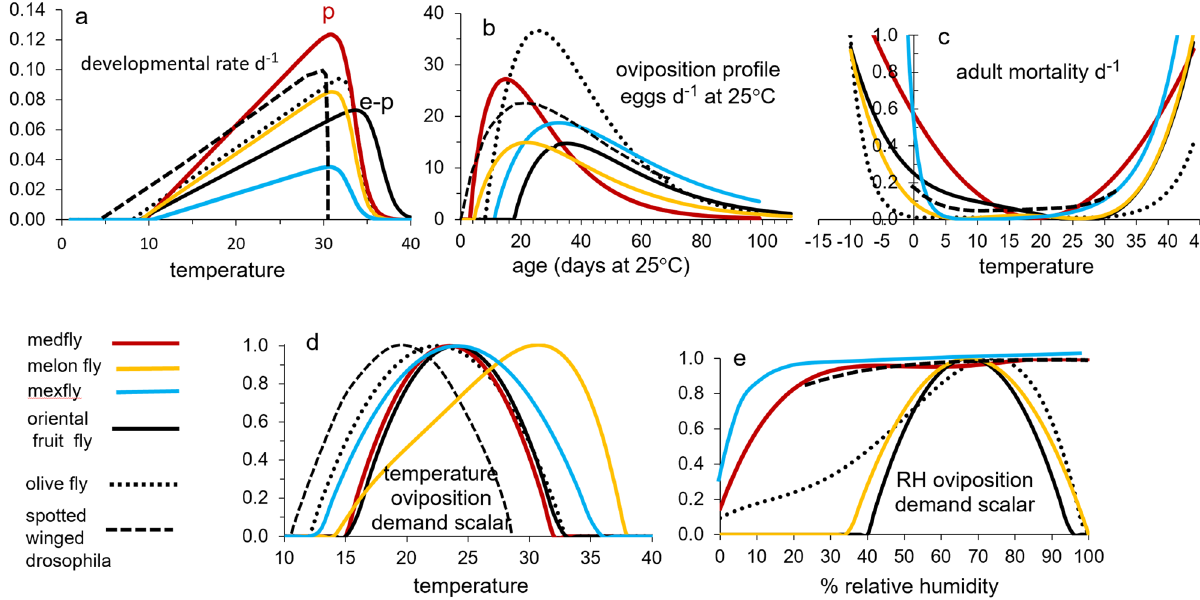
Fig. 1 A summary of the biodemographic functions (BDFs) for six fruit fl ies. a Rates of development on temperature (symbols e-p are egg-pupal stages for melon fl y and oriental fruit fl y, p for med fl y pupal stage, and all others are e-l for egg-larval stages), b the age speci fi c oviposition pro fi les, c temperature dependent mortality rates, and d , e are temperature ( ϕ (T) ) and relative humidity ( ϕ (RH) ) scalars for adult reproduction. The the BDFs and paramenters for the four fruit fl ies in this study are presented in Figs. 5 – 8 and Table 2, and the data are reported in Supplementary EXCEL fi les S1 – S4. The BDFs and parameters for olive fl y and spotted wing dosophila are reported in Supplementary Table